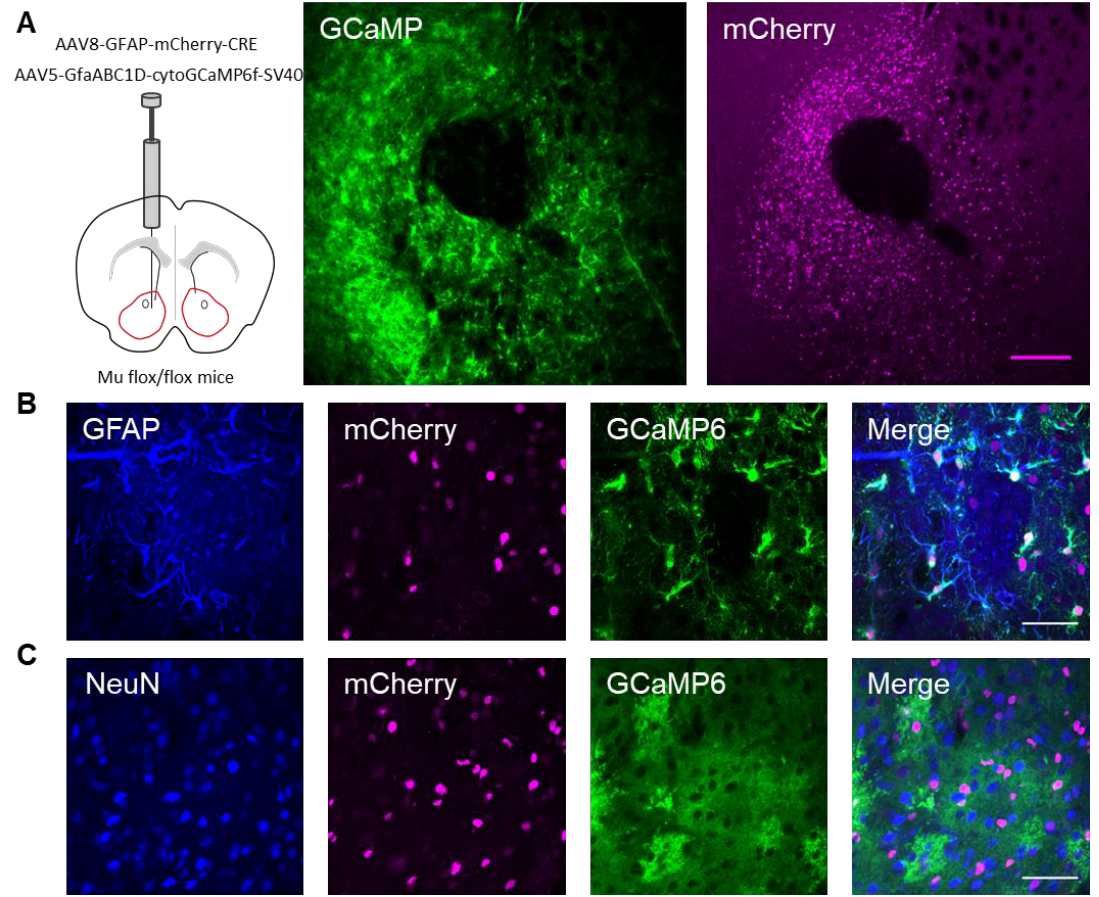
Figure 4. Targeting AAV8–GFAP–mCherry–CRE to astrocytes in the nucleus accumbens of µ-flox mice. ( A ) Scheme of viral targeting experimental approach and immunohistochemistry images of GCaMP6 (green) and AAV8–GFAP–mCherry–CRE (magenta) in the nucleus accumbens. ( B ) Immunohistochemistry images of mCherry + cells co-stained with GFAP and GCaMP6, and the merge image in the nucleus accumbens. ( C ) Immunohistochemistry images of mCherry + cells co-stained with NeuN and GCaMP6, and the merge image in the nucleus accumbens. Magenta scale bar = 200 µm, white scale bar = 50 µm. Table 2. AAV8 – GFAP – mCherry – CRE viral vector specificity quantification. Condition Cells with Co-Expression/Total # Cells